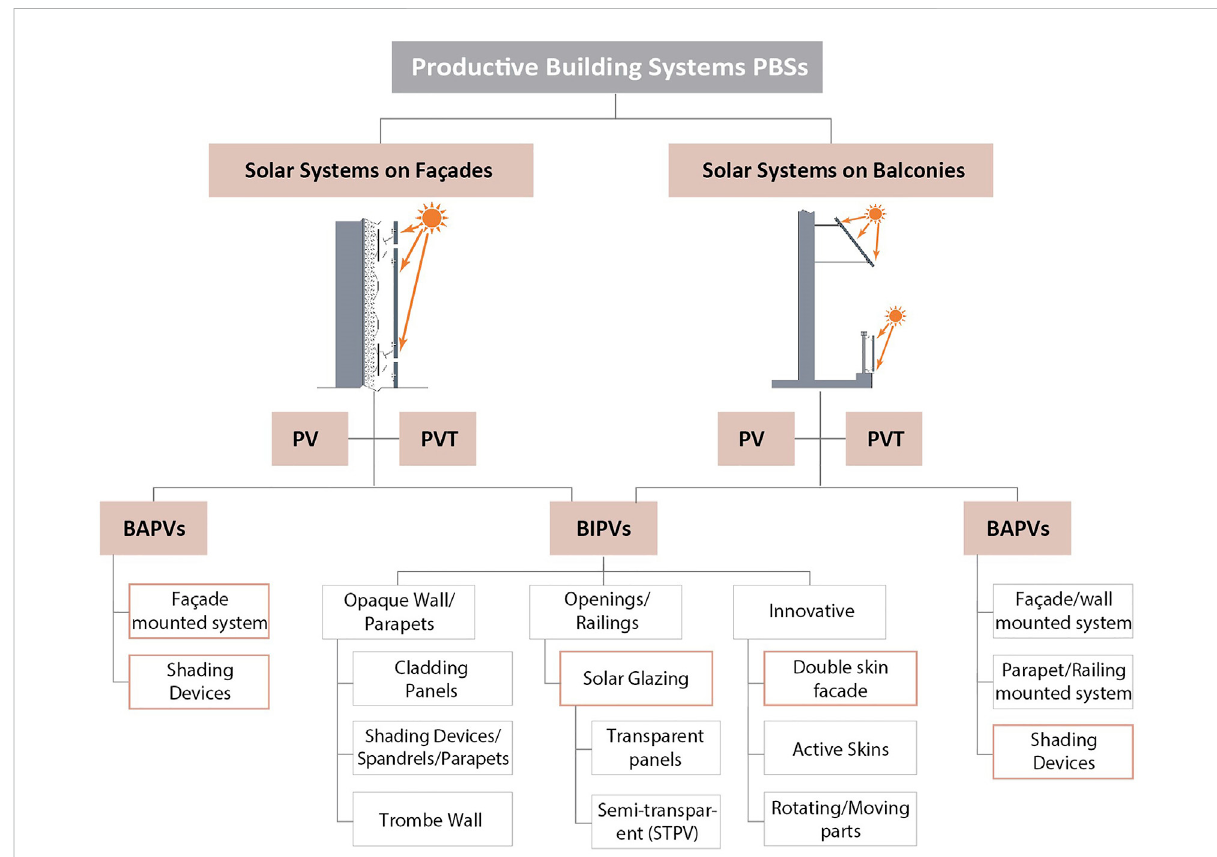
FIGURE 8 Inventory of solar energy systems (BAPVs and BIPVs) on façades and balconies, compiling the types and classi fi cations identi fi ed from assessed studies and reports to createthe body of classi fi cation (all boxes). Structured based on (Saber et al., 2014;Boemiet al., 2016; Attoye et al., 2017; Biyik etal., 2017; Shukla et al., 2017;Ghosh, 2020; Singh et al., 2021)with additions. Systemsexisting inthe Egyptian market are highlightedby thebrown- bordered boxes. PBSs, Productive Building Systems; BAPVs, Building-Applied Photovoltaics; BIPVs, Building-Integrated Photovoltaics; PVs, Photovoltaic panels; PVTs, Photovoltaic thermal systems; STPV, Semi-Transparent